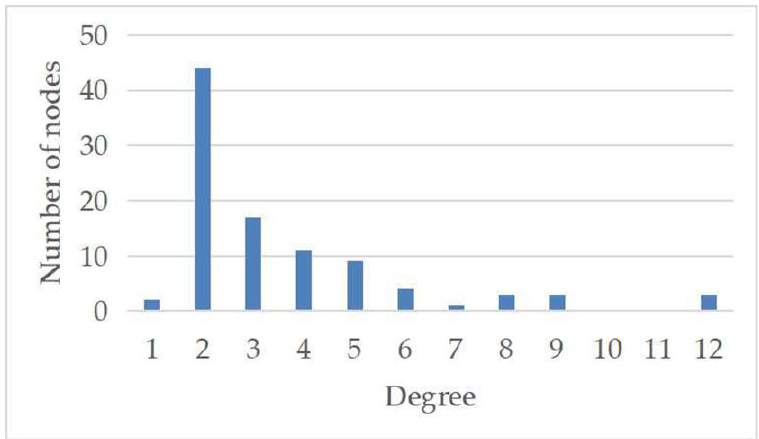
Figure 3. Node degree of traffic complex network.